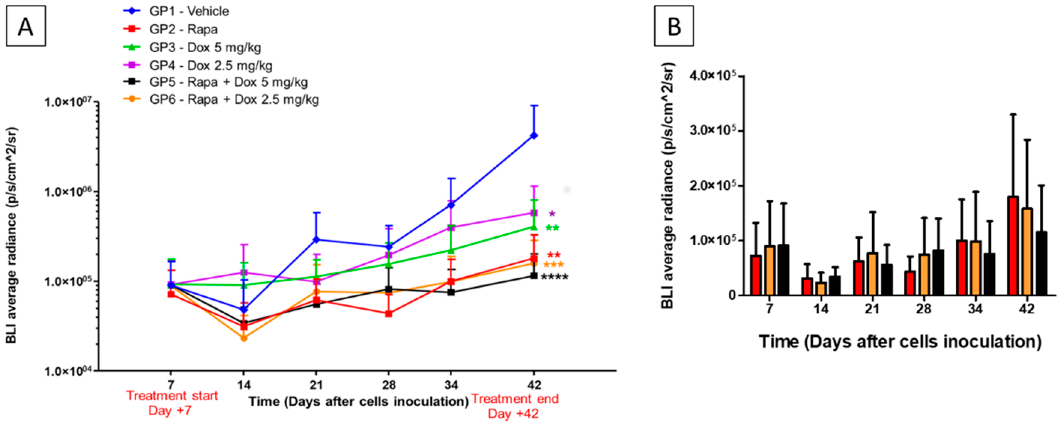
Figure 4. Cont. Figure 4. Cont